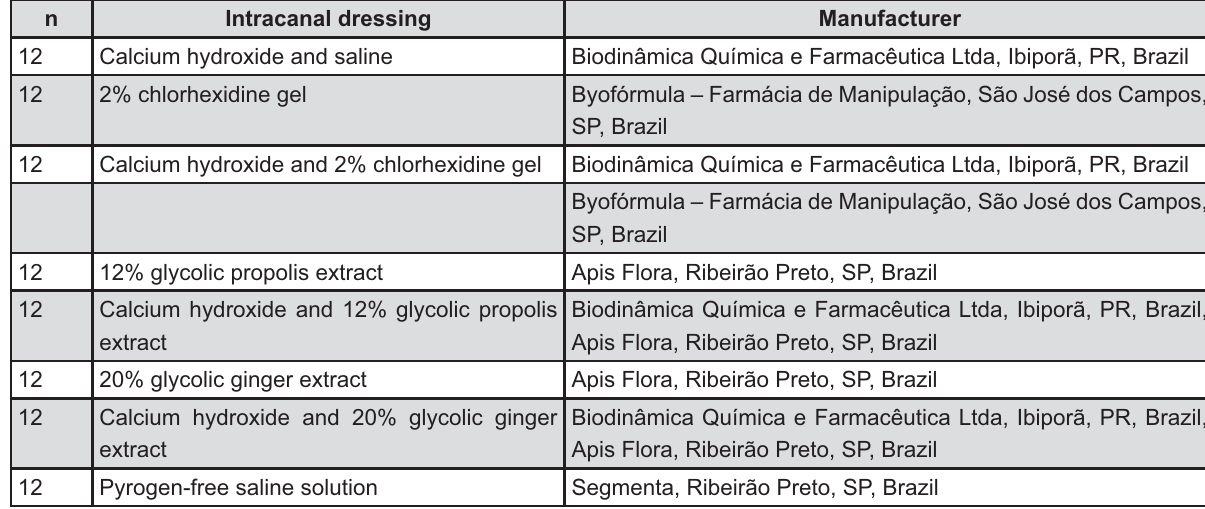
Figure 2- Distribution of